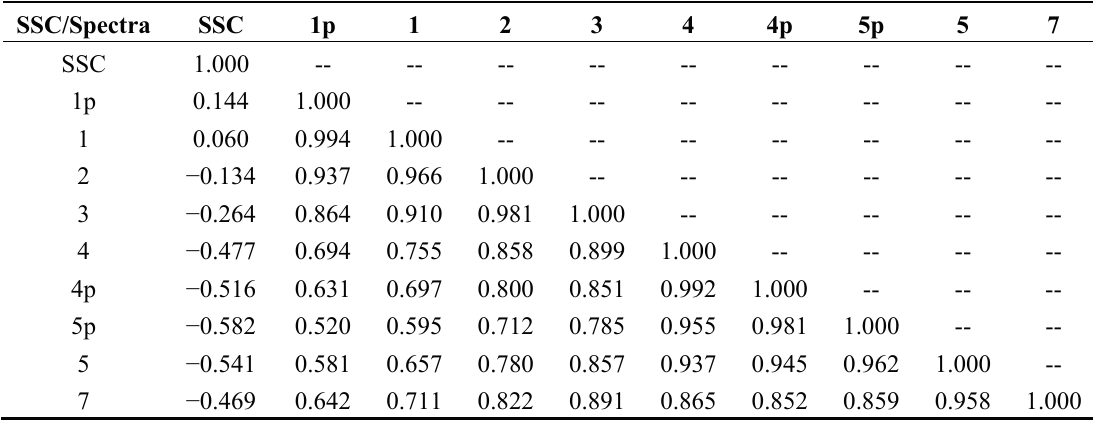
Table 4. Correlation coefficients between soil salinity and ALI-convolved field spectra and coefficients between ALI-convolved field